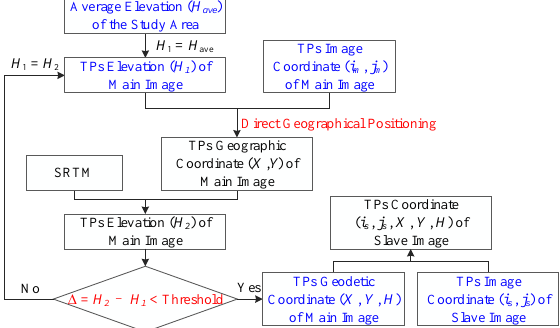
Figure 2. Flowchart of obtaining TP’s geodetic coordinate based on SRTM DEM